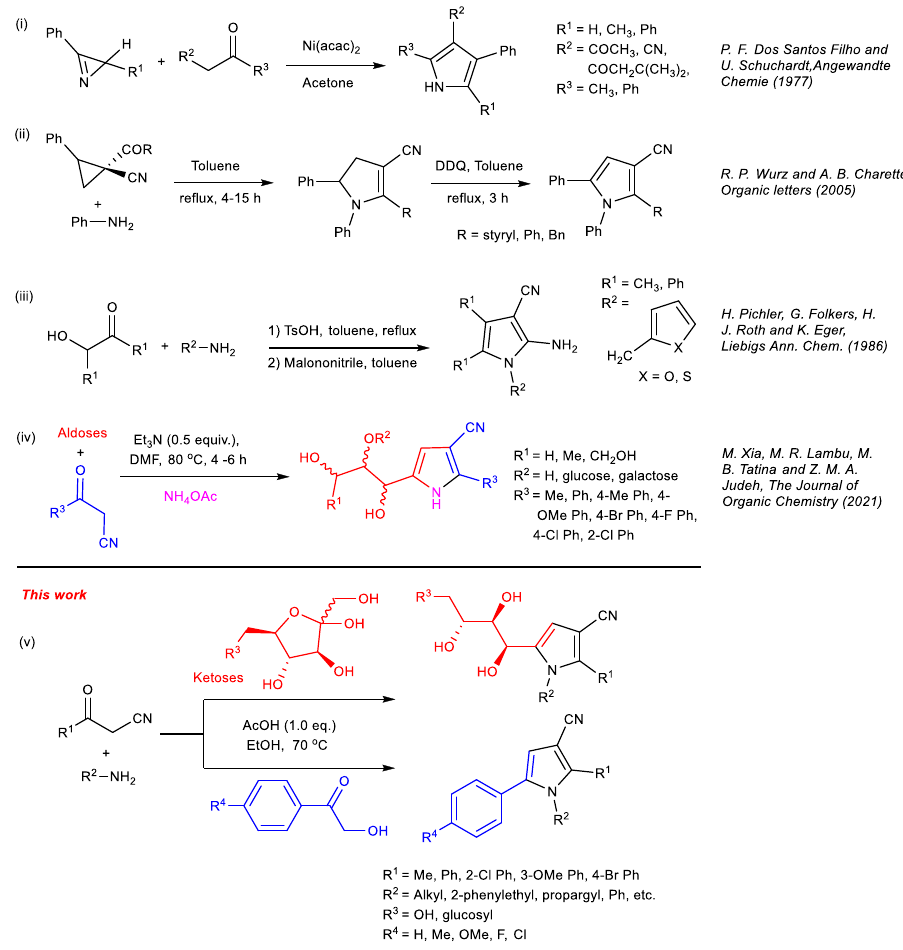
Figure 2. Previous and proposed work for the synthesis of 3-cyanopyrroles.